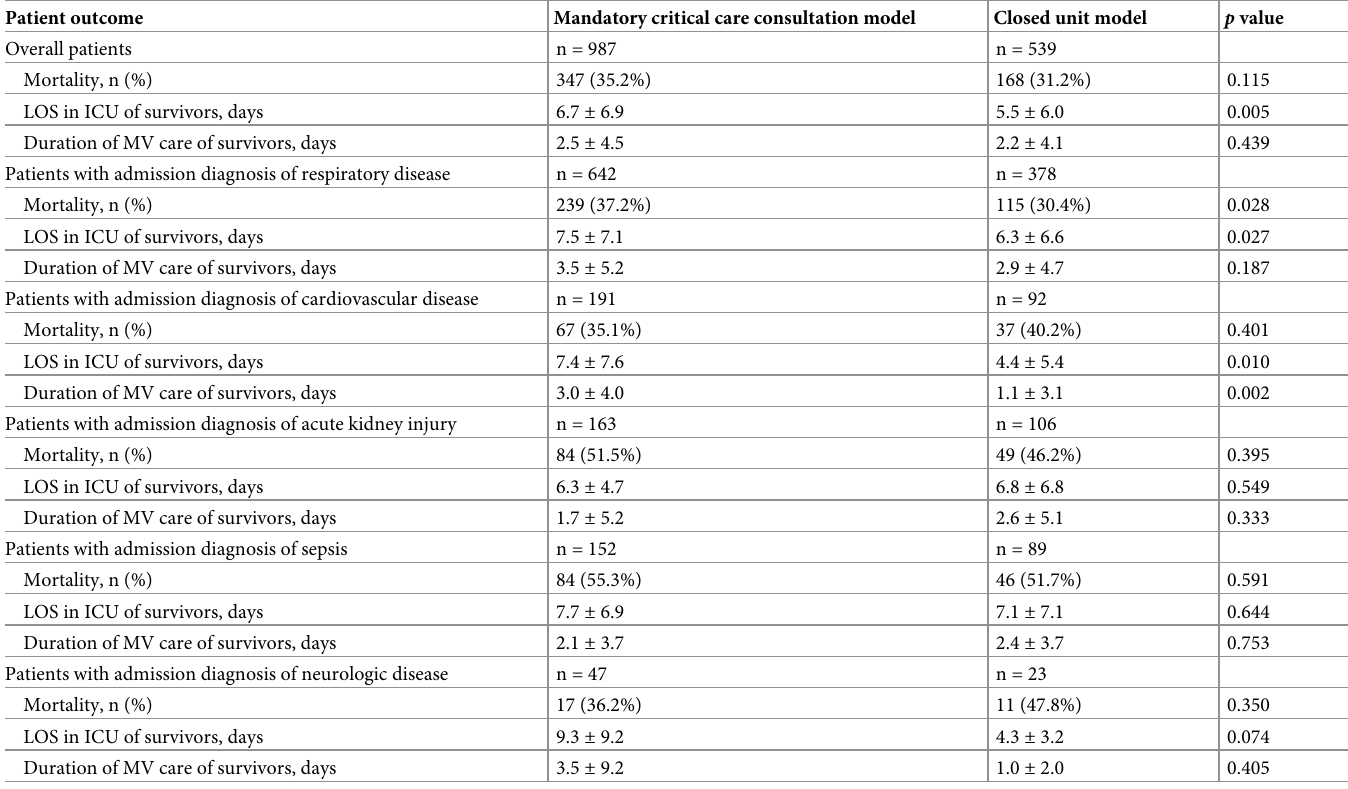
Table 5. Patient outcomes changes in the five subgroups according to the staffing model of